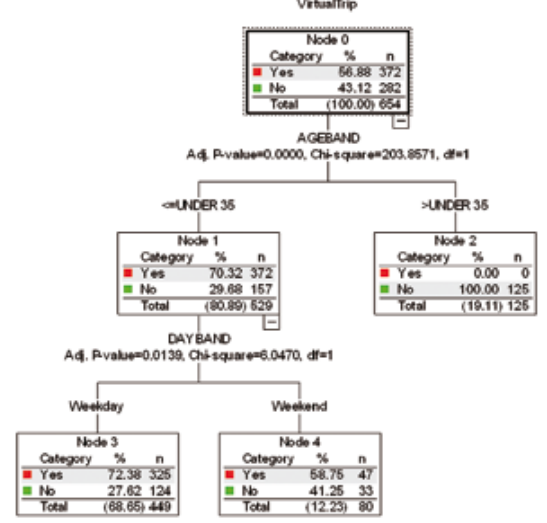
Fig. 4. Answer tree: what conditions influence whether virtual trip was made?